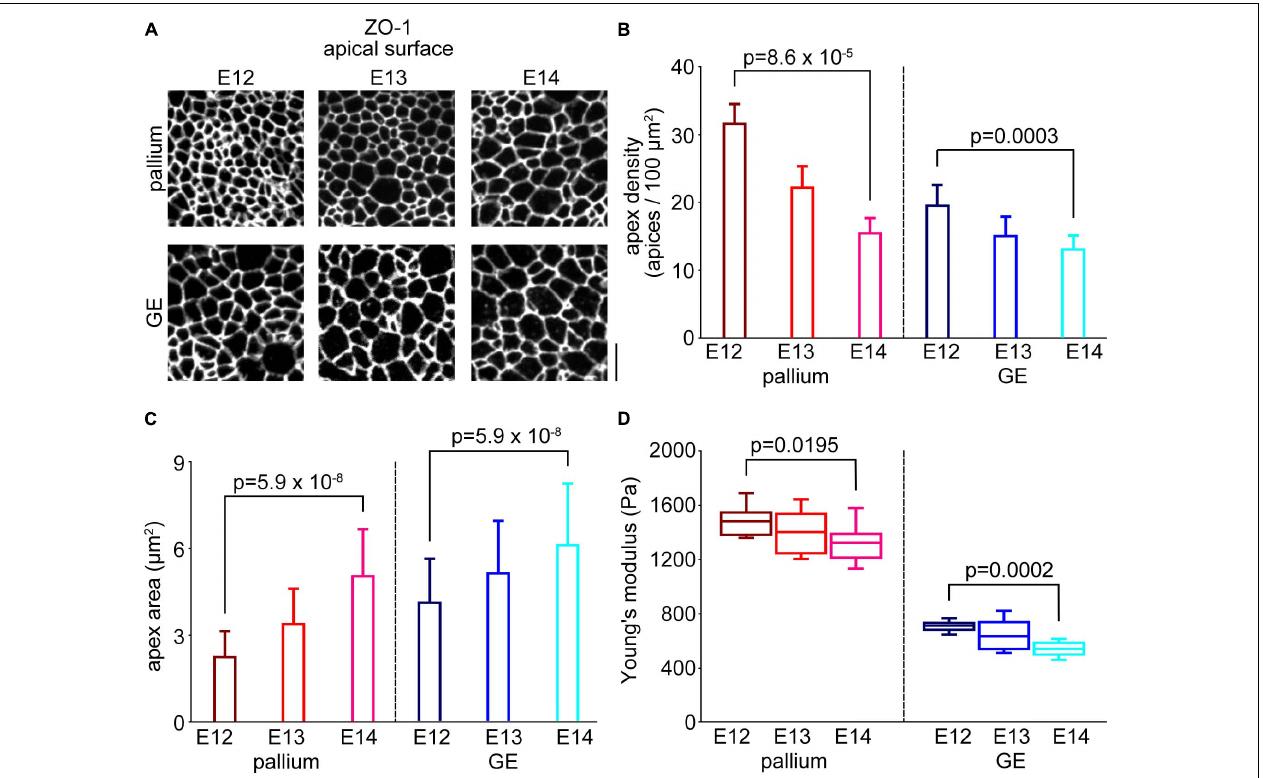
FIGURE 5 | Comparison with the horizontal densities of endfeet between the pallium and the GE. (A) En face photomicrographs of the apical surface immunostained with anti-ZO1, showing junction meshwork patterns in the pallium and the GE from E12 to E14. Scale bar, 5 µ m. (B) Graph showing the densities of apices in the pallium ( n = 12 area from six embryos for E12, n = 12 area from seven embryos for E13, n = 12 area from seven embryos for E14) ( p = 8.6 × 10 − 5 , Steel–Dwass test) and the GE ( n = 12 area from three embryos for E12, n = 12 area from three embryos for E13, n = 12 area from four embryos for E14) ( p = 0.0003, Steel–Dwass test) from E12 to E14. (C) Graph showing the averaged area of the apex of each NPC endfoot in the pallium ( n = 533 apices from eight embryos for E12, n = 511 apices from seven embryos for E13, n = 514 apices from seven embryos for E14) ( p = 5.9 × 10 − 8 , Steel–Dwass test) and GE ( n = 524 apices from three embryos for E12, n = 530 apices from six embryos for E13, n = 514 apices from seven embryos for E14) ( p = 5.9 × 10 − 8 , Steel–Dwass test) cerebral walls from E12 to E14. (D) Graph showing the Young’s modulus measured vertically on the apical surface in the pallium ( n = 10 pieces for E12, n = 11 pieces for E13, n = 15 pieces for